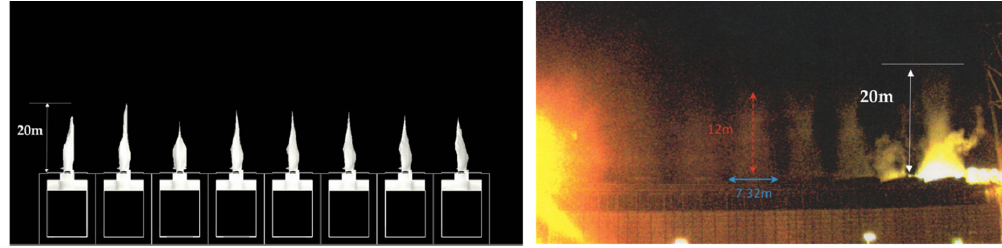
Figure 9. Comparisons of calculated and observed visible plume under dry and wet operation.